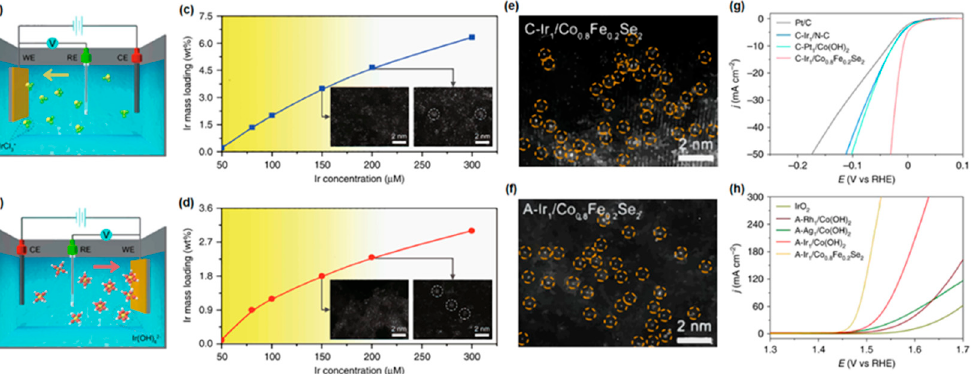
Figure 5. Schematic of ( a ) cathodic and ( b ) anodic deposition of Ir SACs. Differences in Ir mass loadings according to the concentration of IrCl 3 for ( c ) cathodic and ( d ) anodic deposition. HR-TEM images of ( e ) cathodically and ( f ) anodically deposited Ir SAs on Co 0.8 Fe 0.2 Se 2 support. Polarization curves of ( g ) cathodically deposited SACs for HER and ( h ) anodically deposited SACs for OER on various substrates. The Ir SAs on Co 0.8 Fe 0.2 Se 2 support showed the best catalytic performance in both HER and OER (loading of cathodically and anodically deposited Ir SAs on Co 0.8 Fe 0.2 Se 2 : 2 wt.% and 1.2 wt.%, respectively). Reprinted (adapted) from [111], copyright (2023) Springer Nature Limited.